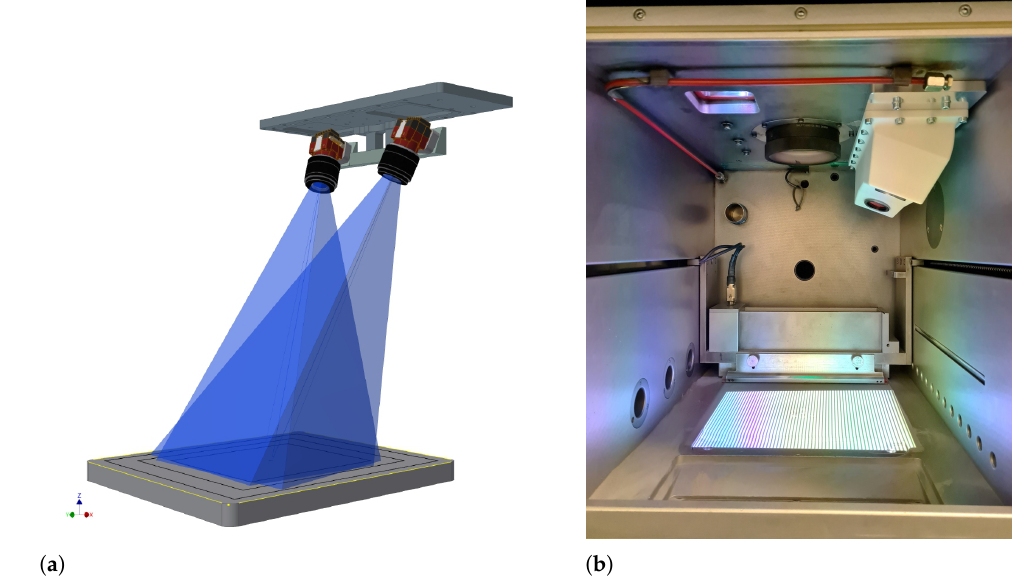
Figure 13. In-process measurement system. ( a ) CAD-Drawing of the dimensions and positions of the measuring system within the installation space. The calculated vision rays of the cameras on the building board are drawn in blue. For best practice, both cameras should capture the same field of view (here for the size of 150 × 150 mm). ( b ) Installation and test of the measuring system inside the Realizer 250 system of BIAS. A 3D printed, temperature-stable hood (white) shields the process. The reference pattern is projected from outside through a viewing window.